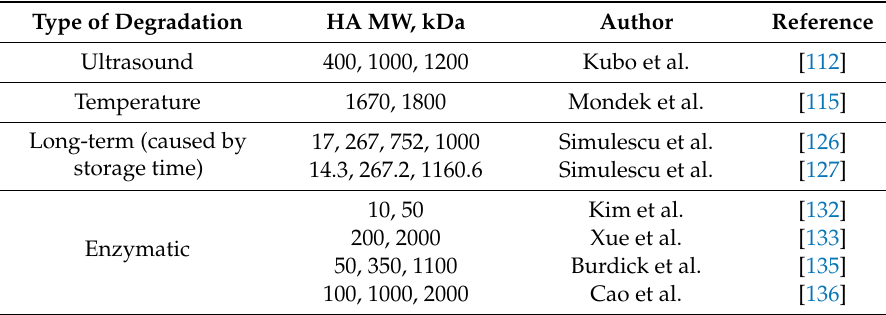
Table 8. Summary of degradable properties of hyaluronic acid with different molecular weight. Type of Degradation